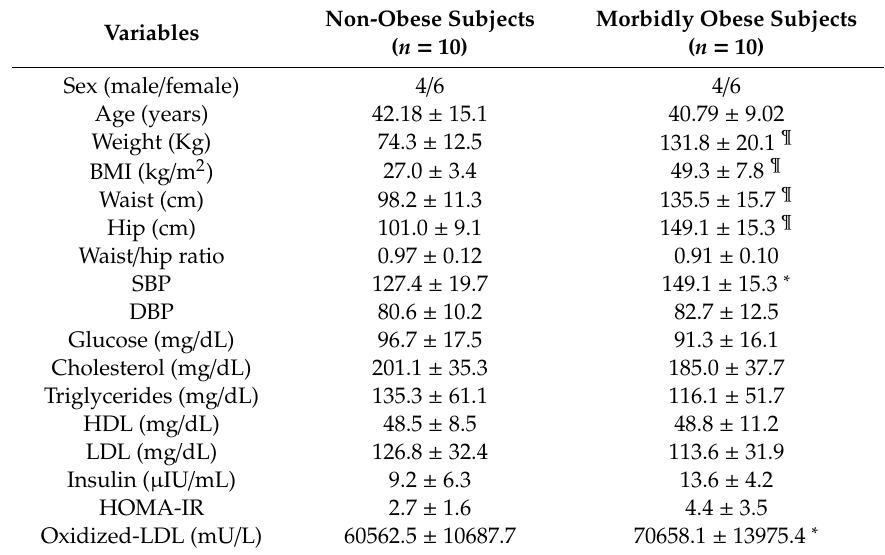
Table 1. Anthropometric and biochemical variables of the non-obese and morbidly obese subjects included in this